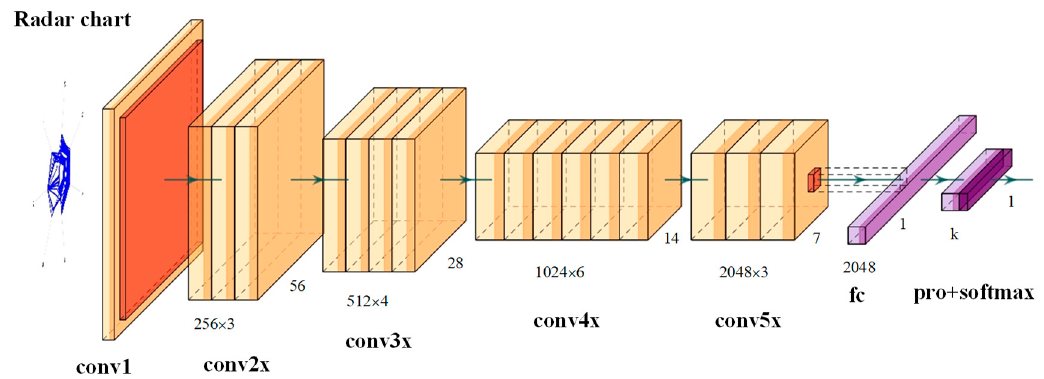
Figure 5. ResNet50 network structure.